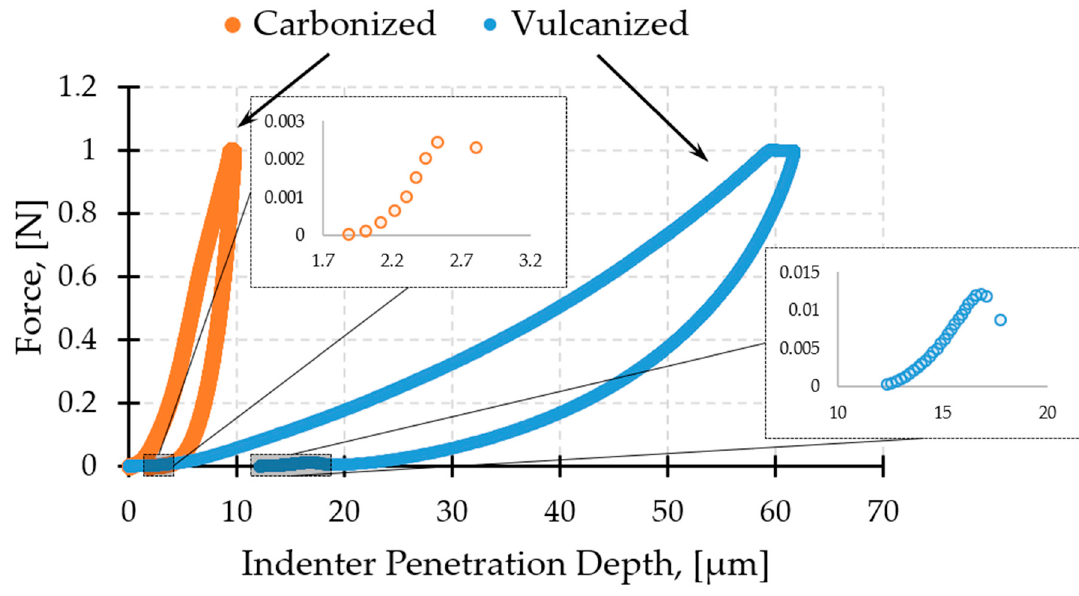
Figure 17. Typical load–displacement curve at nanoindentation.